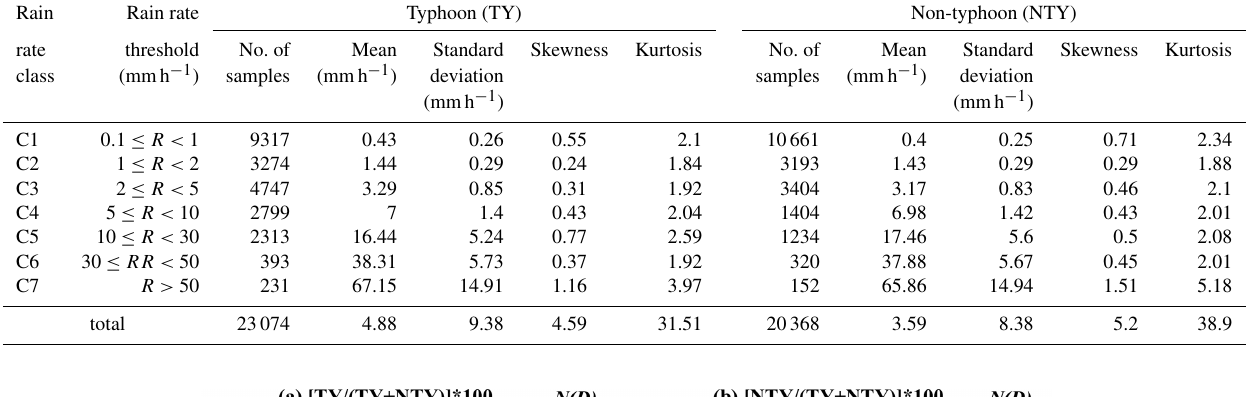
Table 2. Rainy minutes ( N ), mean, standard deviation (SD), skewness, and kurtosis of seven rainfall rate classes for typhoon (TY) and non-typhoon (NTY) rainy days of summer seasons.